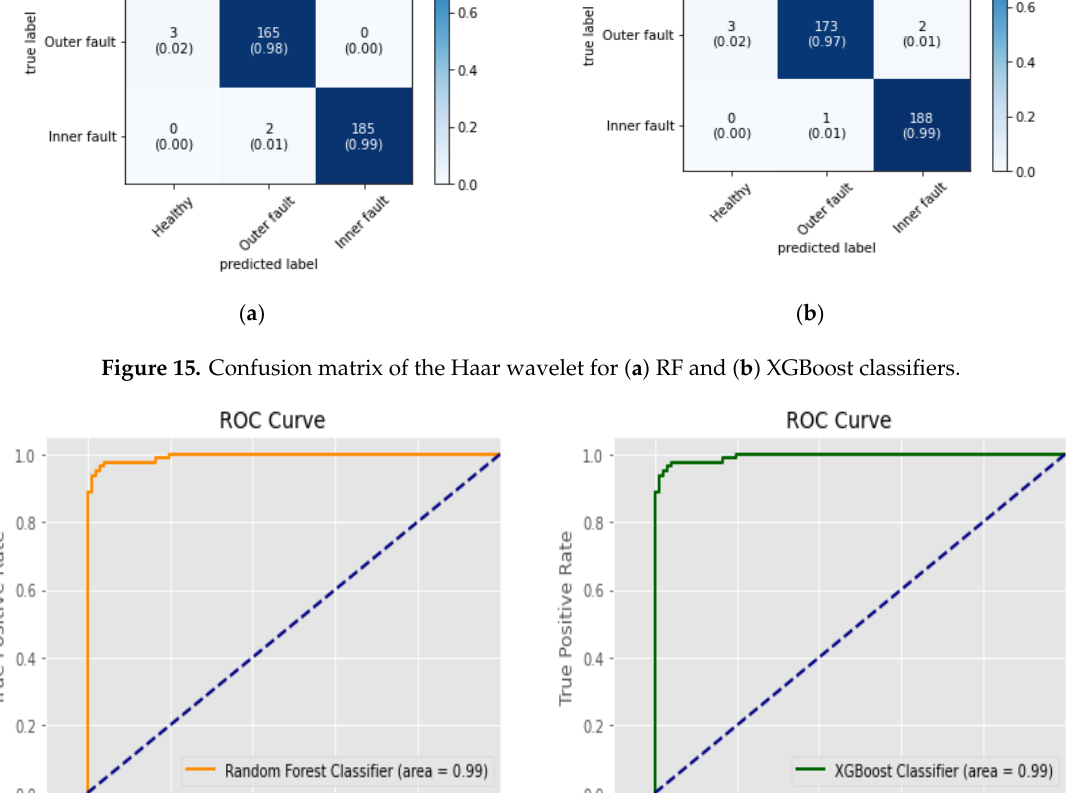
Table 8. Comparison of classification accuracy among the various methods. Applied Methodology